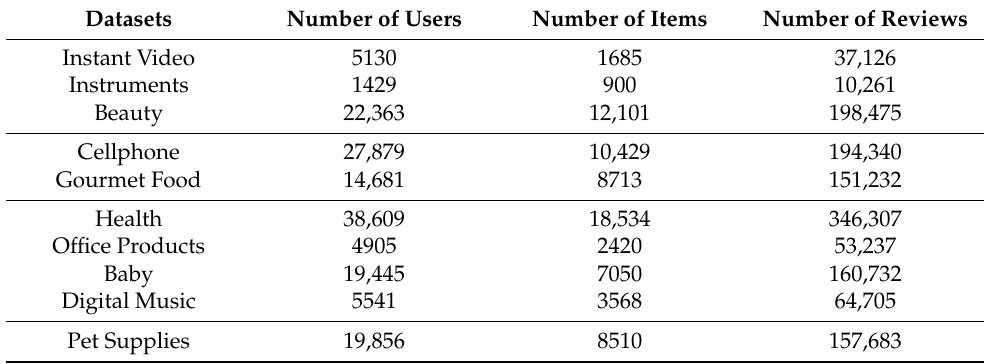
Table 2. The statistics of the ten Amazon